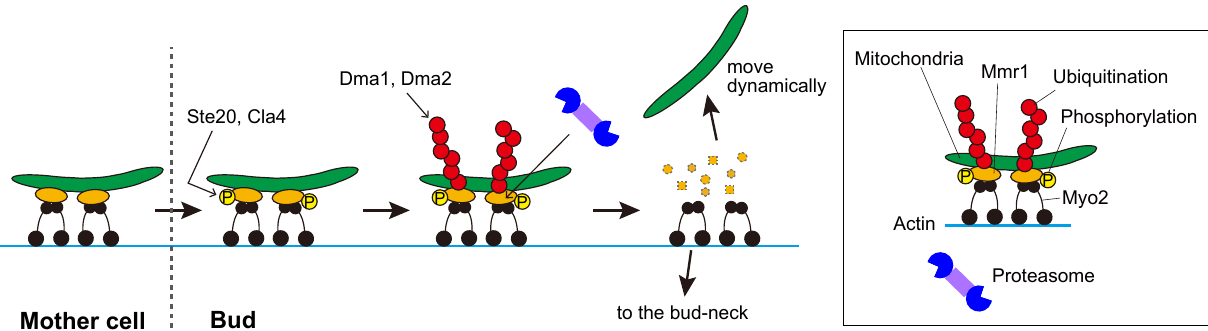
FIGURE 1: Mechanism of mitochondria release from myosin during budding. Mitochondria are transported into the growing bud by a type-V myosin Myo2 on the actin cable. Mmr1 bridges mitochondria and Myo2. After mitochondria enter the bud, Mmr1 is phosphorylated, most likely at the S414 residue, by Ste20 or Cla4. Phosphorylated Mmr1 is ubiquitinated by redundant E3 ubiquitin ligases Dma1 and Dma2. Polyubiquitinated Mmr1 is degraded by the proteasome, resulting in dissociation of mitochondria from Myo2. The released mitochondria move dynamically in the bud while Myo2 translocates to the bud-neck to play a role in cytokinesis. As Ste20 and Cla4 are mostly localized to the bud cortex region and nearly absent in the mother cell, phosphorylation of Mmr1 and its turnover take place only after the mitochondria reaches the bud, which may be the mechanism to ensure mitochondrial inheritance to daughter